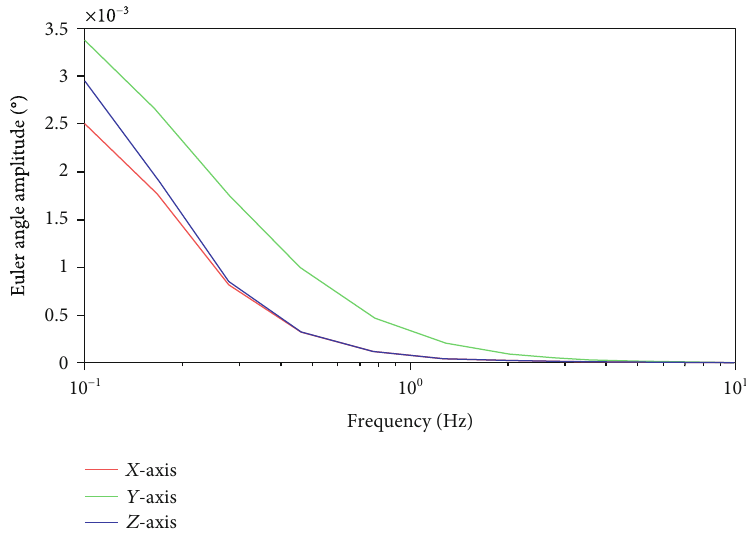
Figure 14: Magnitude-frequency characteristic of the neural network